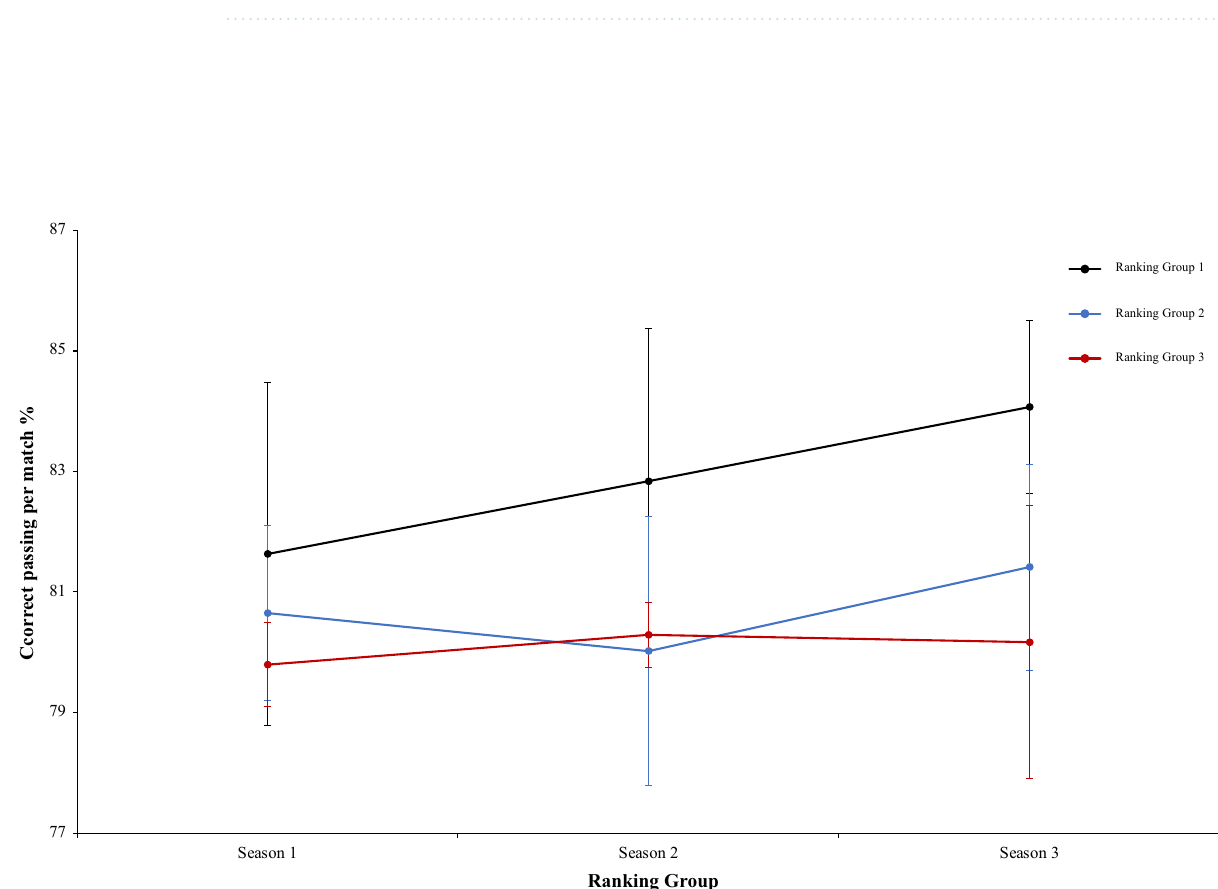
Figure 9. Technical performance. Mean playing the ball percentage (± SE) as a funtion of Group and Season Condition.